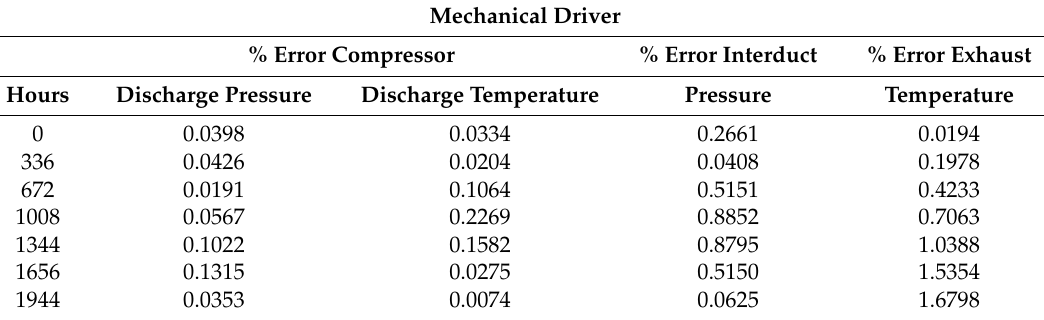
Table 3. Error between fitted and simulated data at low power operation (mechanical driver).